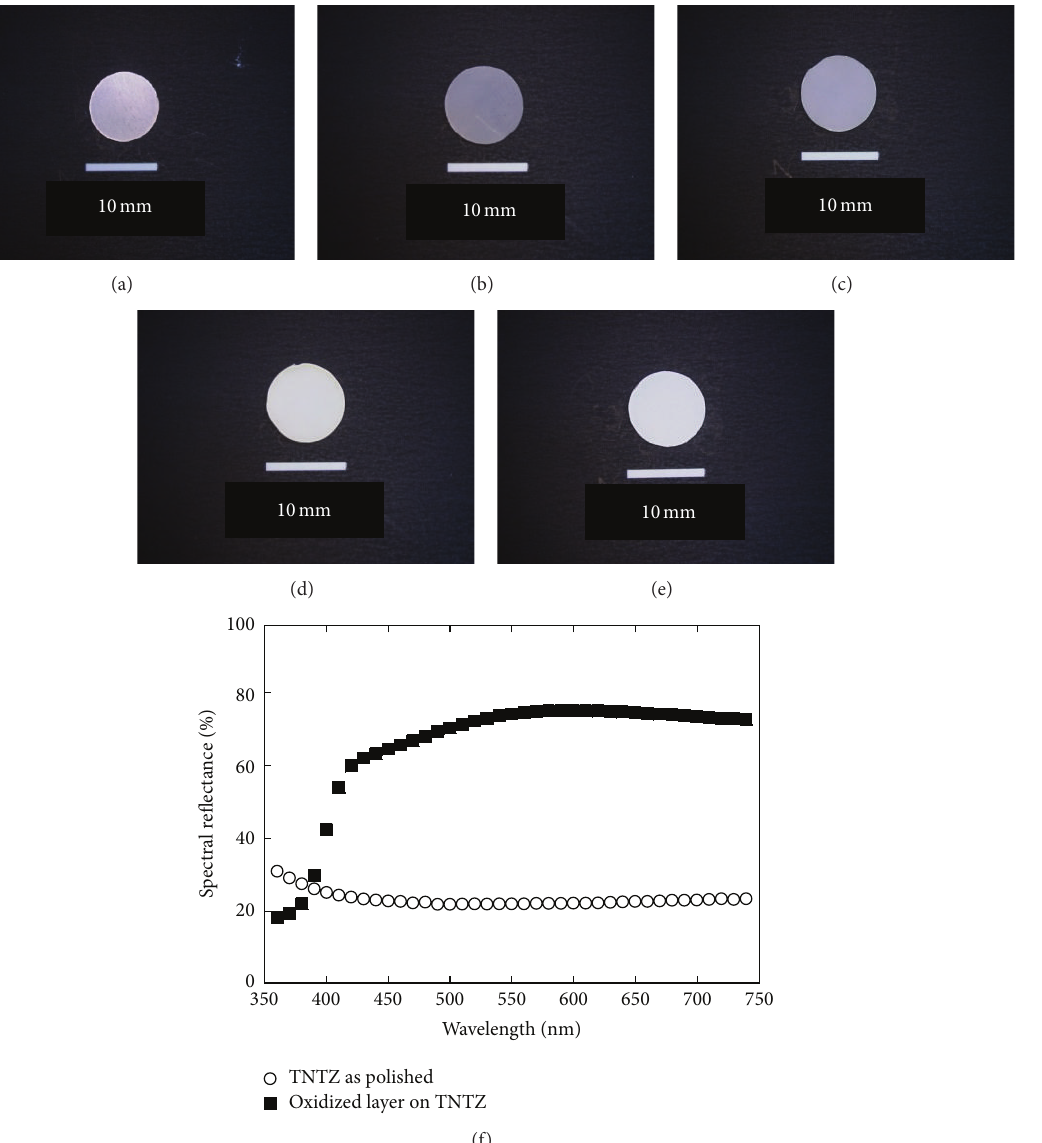
Figure 1: Appearances of TNTZ samples. (a) As-prepared, (b) heated at 900 ∘ C for 0.5hr, (c) heated at 900 ∘ C for 1hr, (d) heated at 1000 ∘ C for 0.5 hr, and (e) heated at 1000 ∘ C for 1hr. Spectral reflectances of TNTZ samples before and after heat-treatment at 1000 ∘ C for 0.5 hr